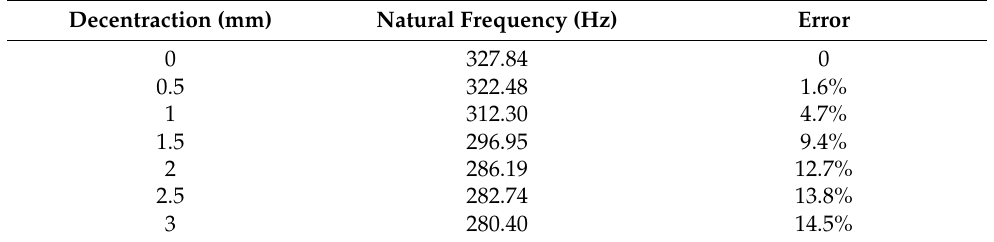
Table 4. The 5th order natural frequency error under different parallel non-concentricity of the 3rd order.